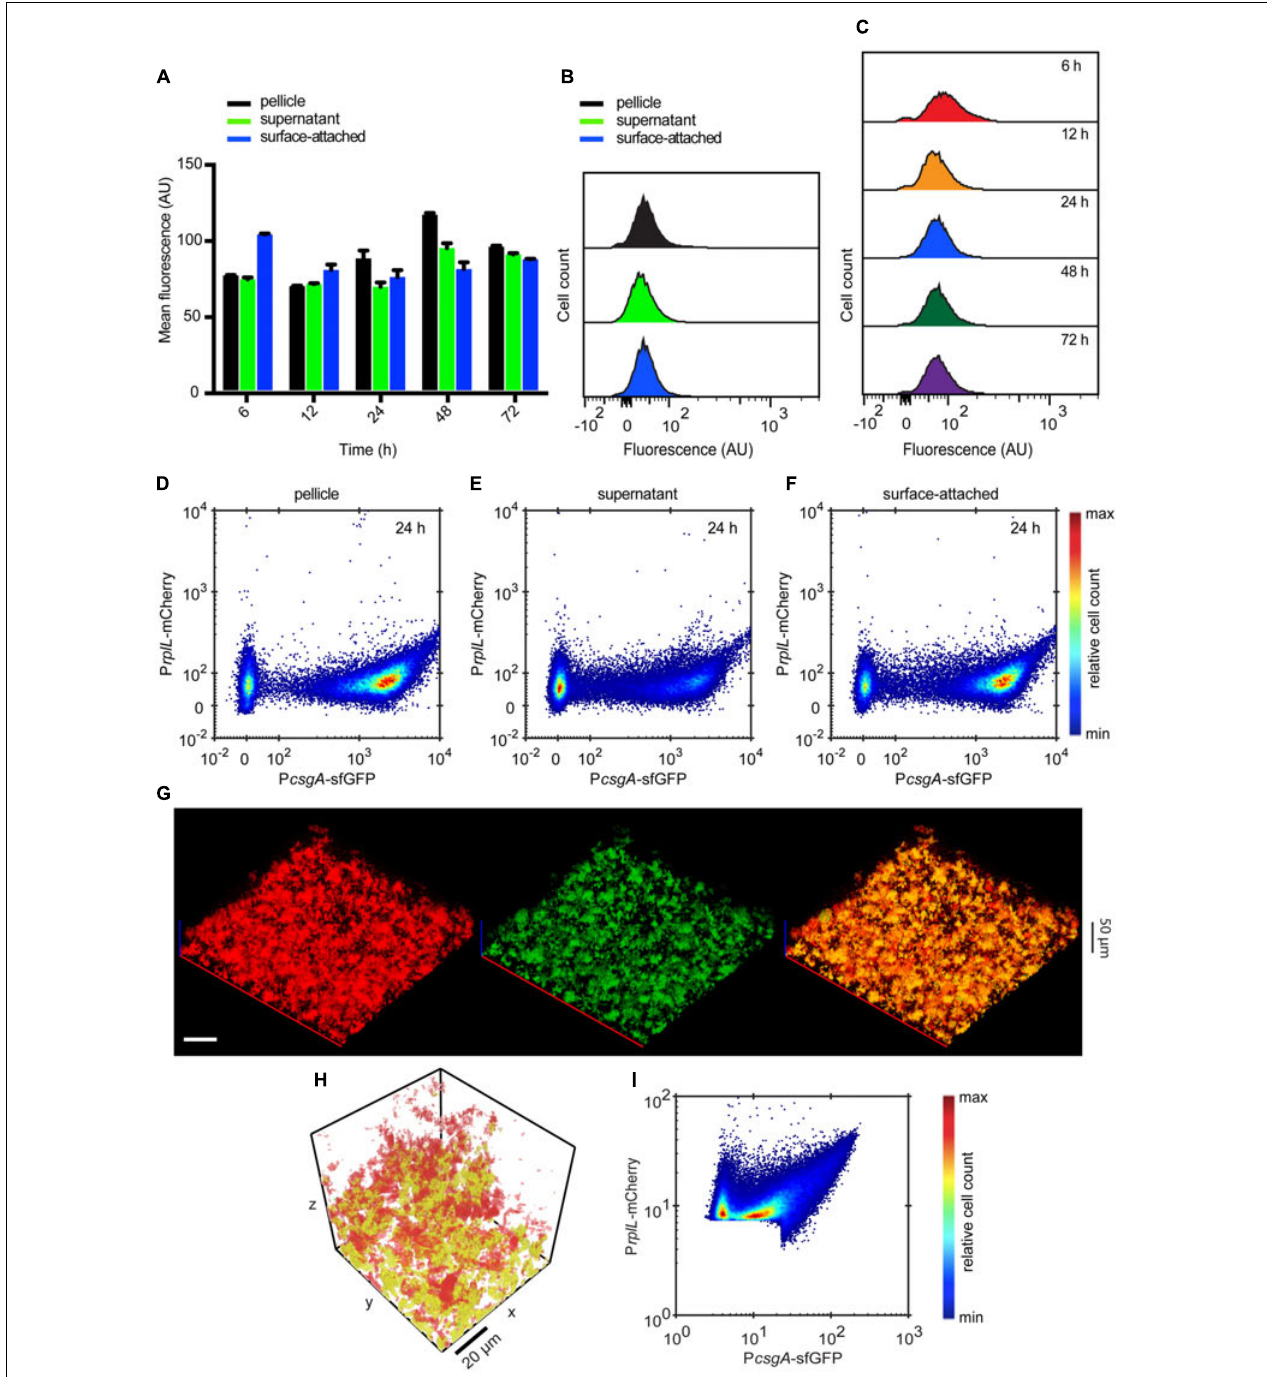
FIGURE 6 | Curli expression is independent of σ D activity. (A) Mean of P rplL -mCherry fluorescence intensity measured in indicated cell fractions by flow cytometry. (B) Flow cytometry analysis of P rplL -mCherry fluorescence detected in individual biofilm fractions at 24 h. (C) Changes in the single-cell expression of σ D reporter measured over time in surface-attached cells. (D − F) Scatter plots showing expression of P csgA -sfGFP and P rplL -mCherry in (D) pellicle, (E) supernatant and (F) surface-attached cells at 24 h. The color scale shows relative cell count from lowest (blue) to highest (red). (G) Confocal fluorescence microscopy images (maximum projection) showing the expression of P csgA -sfGFP (green) and P rplL -mCherry (red) in biofilms at 24 h. Scale bar, 40 µ m. (H,I) Quantification of relative expression of P csgA -sfGFP and P rplL -mCherry in a region of the submerged biofilm shown in (G) , with a visual representation of the segmentation analysis (H) and relative expression in individual segments shown as a scatter plot (I) . In (H) green regions are P csgA -sfGFP-positive, red regions are P rplL -mCherry-positive and cells in yellow volumes express both fluorescence markers. Note that sharp cutoffs in (I) correspond to the segmentation thresholds applied in image analysis (see Materials and Methods). The color scale shows relative cell count from lowest (blue) to highest (red).